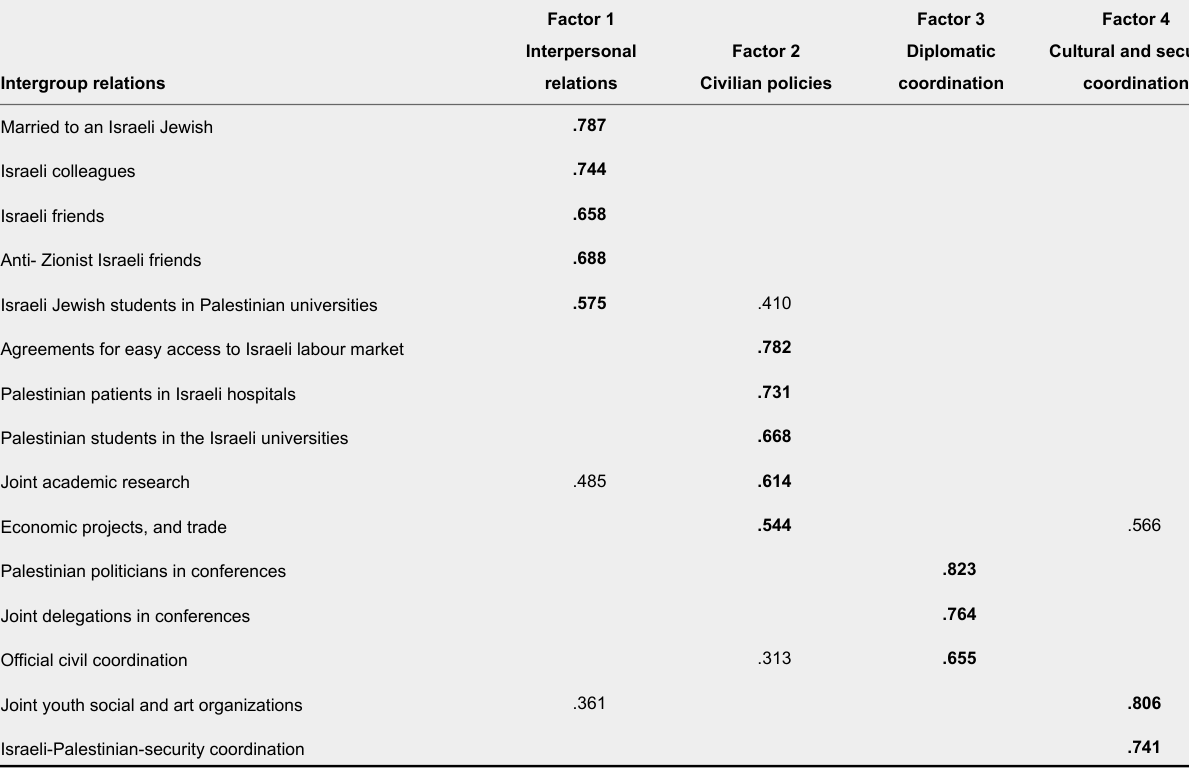
Factor Loadings Based on Principal Component Analysis With Matrix Rotation for Normalization Scale